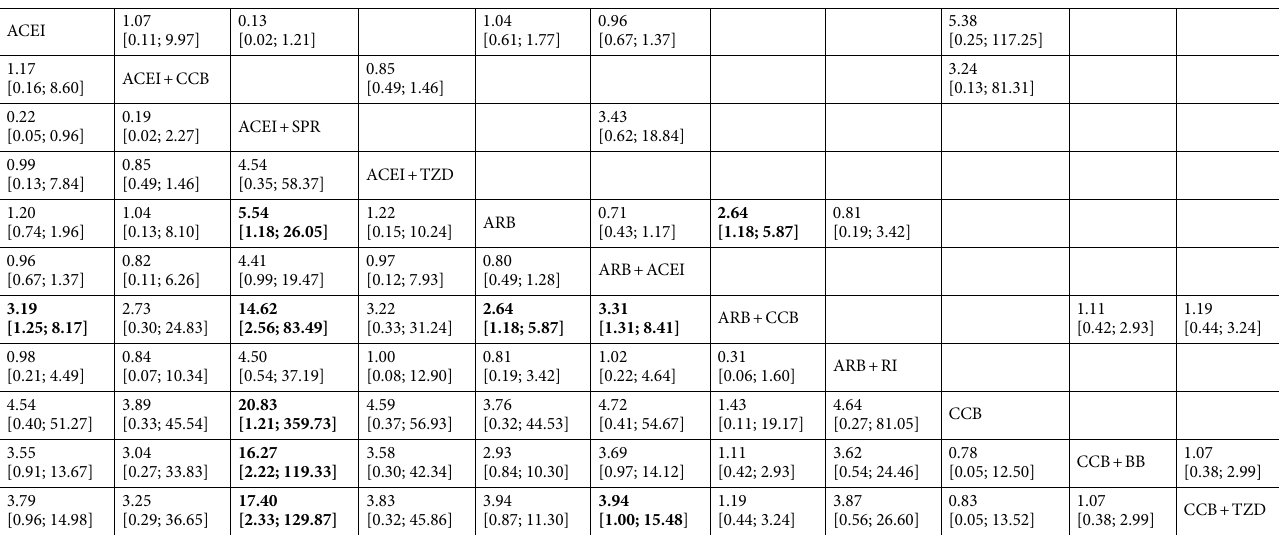
Table 2. Net league table of major CVD events. ACEI, angiotensin converting enzyme inhibitors; ARB, angiotensin receptor blockers; BB, beta-blocker; CCB, calcium channel blockers; CVD, cardiovascular disease; RI, renin inhibitor; SPR, spironolactone; TZD, thiazide diuretics. Statistically significant values are expressed in